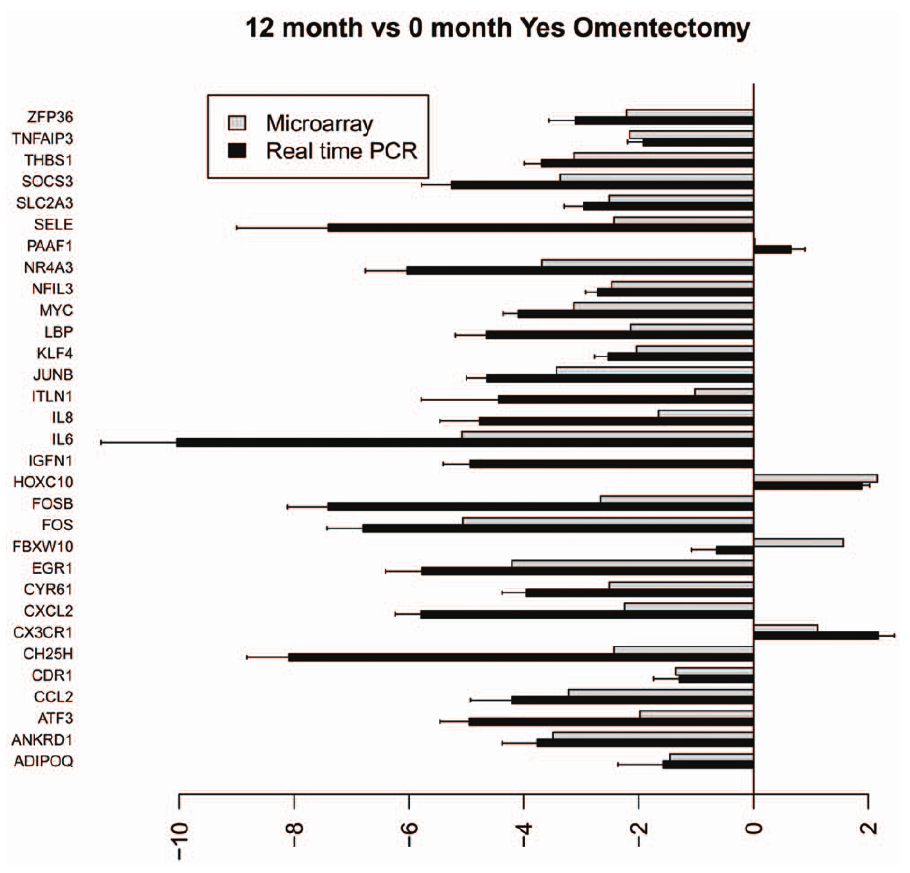
Figure 7. Bar graph illustrating the fold change of individual genes at 12 vs. 0 months with omentectomy as determined by microarray (grey) and TLDA profiling (black).